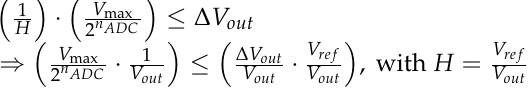
Figure 12. Output voltage response of the optimized digital controllers.